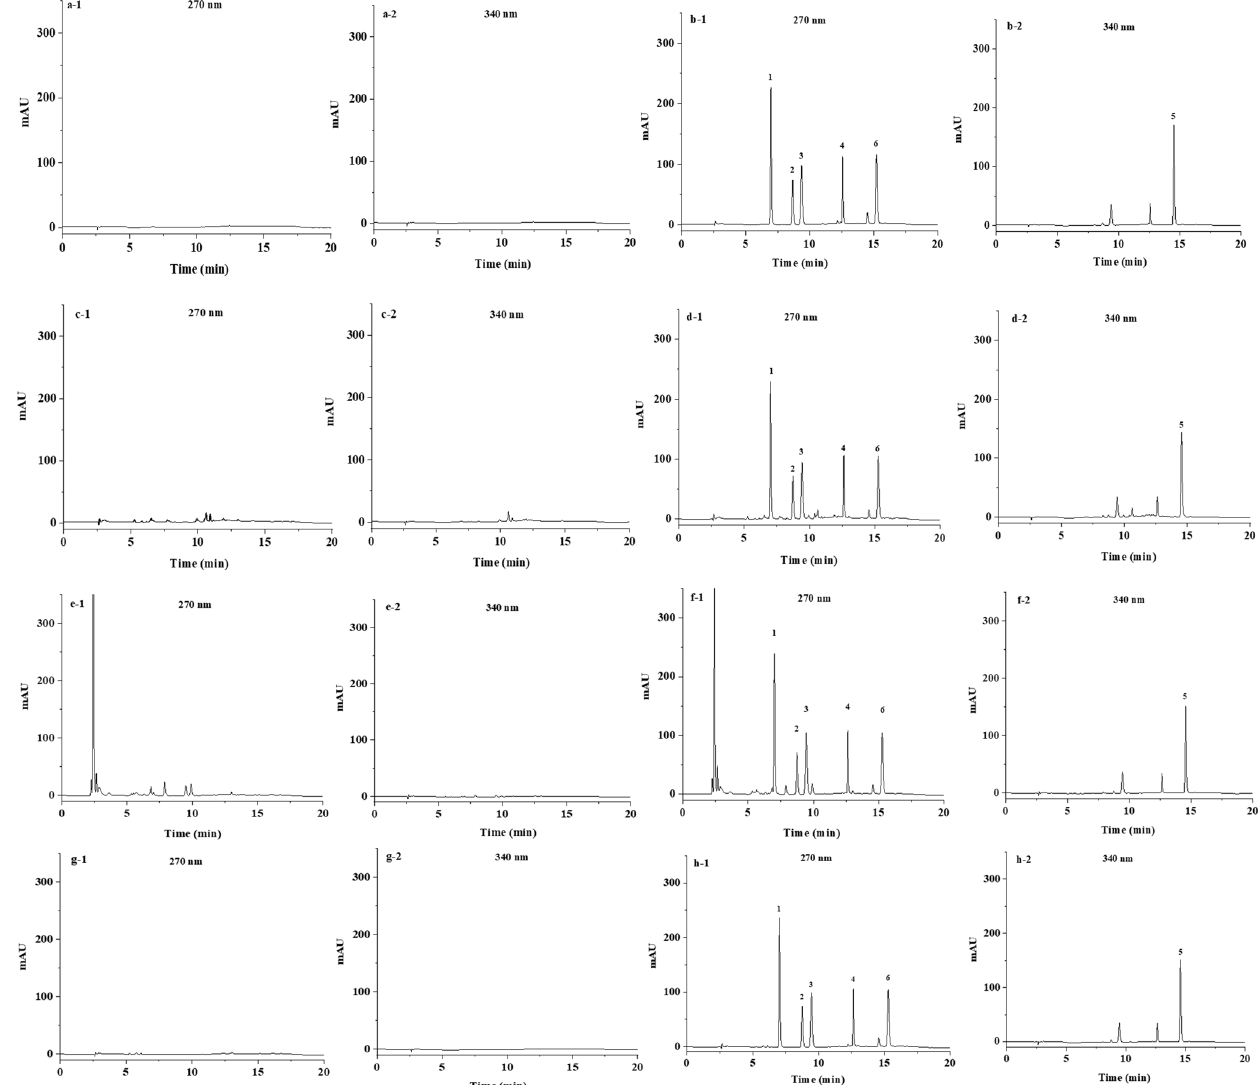
Figure 5. Typical HPLC chromatograms at 270 nm and 340 nm of ( a ) reagent blank, ( b ) reference solution (2 µg/mL), ( c ) blank matrix of chicken premix, ( d ) spiked chicken premix at the concentra- tion of 20 mg/kg, ( e ) blank matrix of chicken complete feed, ( f ) spiked chicken complete feed at the concentration of 20 mg/kg, ( g ) blank matrix of chicken feed additive, and ( h ) spiked chicken feed additive at the concentration of 20 mg/kg, with peak identification as follows: 1, clopidol; 2, dinitol- mide; 3, sulfaquinoxaline; 4, robenidine; 5, nicarbazin; 6, diclazuril.